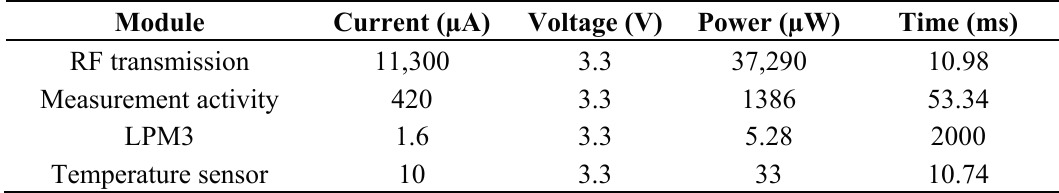
Table 2. Typical parameters of the wireless sensing